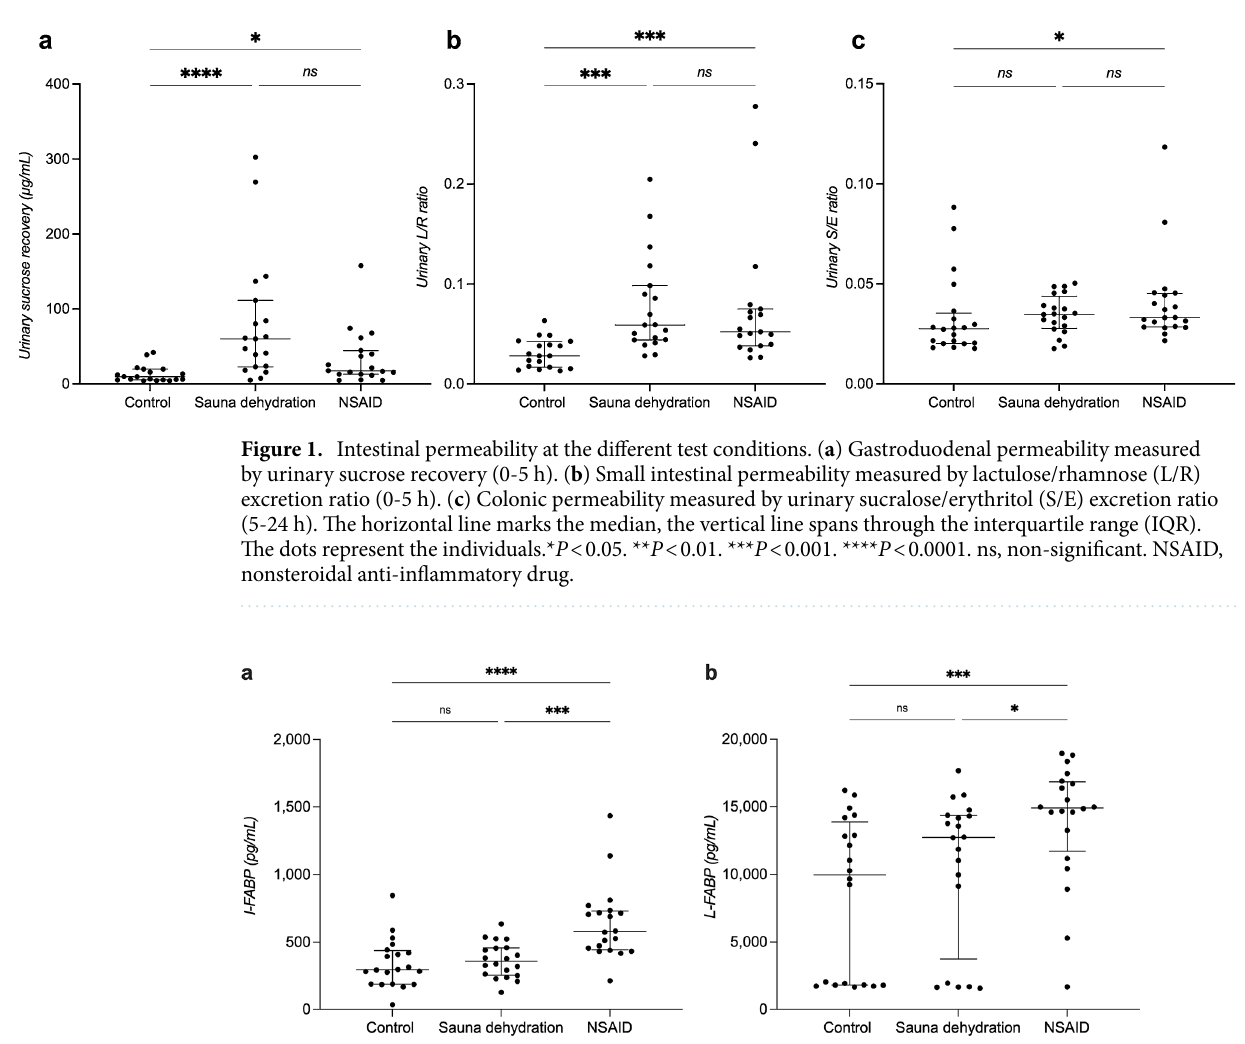
Figure 2. Plasma fatty acid-binding proteins concentrations at the different test conditions. ( a ) Plasma concentrations of intestinal fatty acid-binding protein (I-FABP). ( b ) Plasma concentrations of liver fatty acid-binding protein (L-FABP). The horizontal line marks the median, the vertical line spans through the interquartile range (IQR). The dots represent the individuals. * P < 0.05. **** P < 0.0001. ns, non-significant. NSAID, nonsteroidal anti-inflammatory